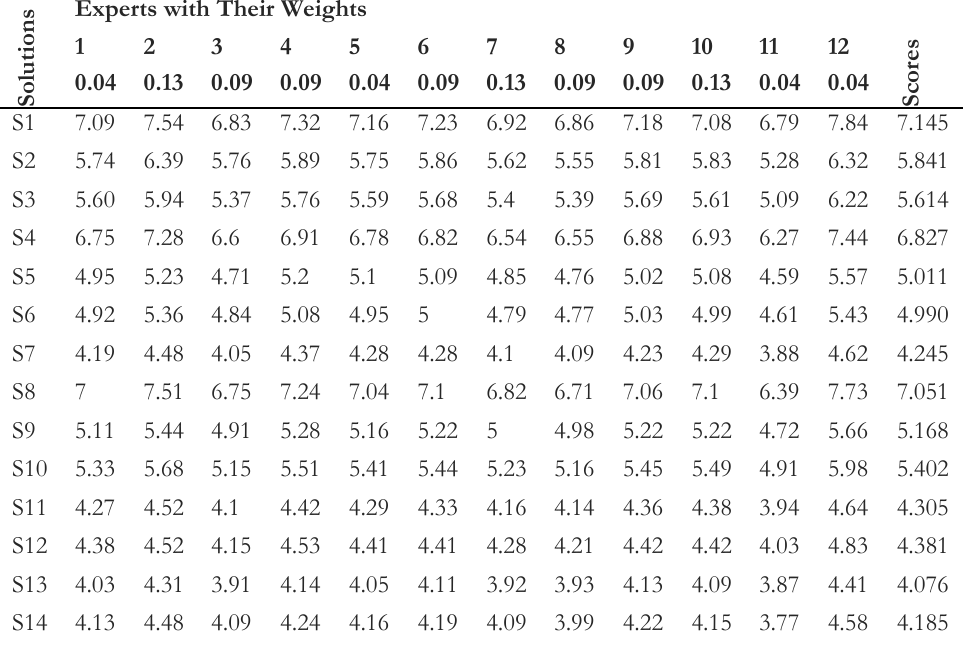
Table 6. The final score for each solution calculated by the weighted summation of all experts’ scores.